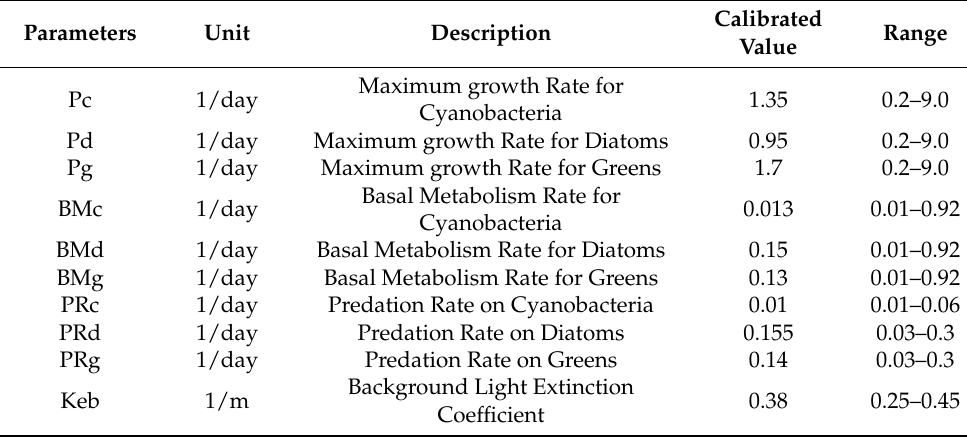
Table A1. The model parameters of Lake Erhai EFDC model and calibrated values.